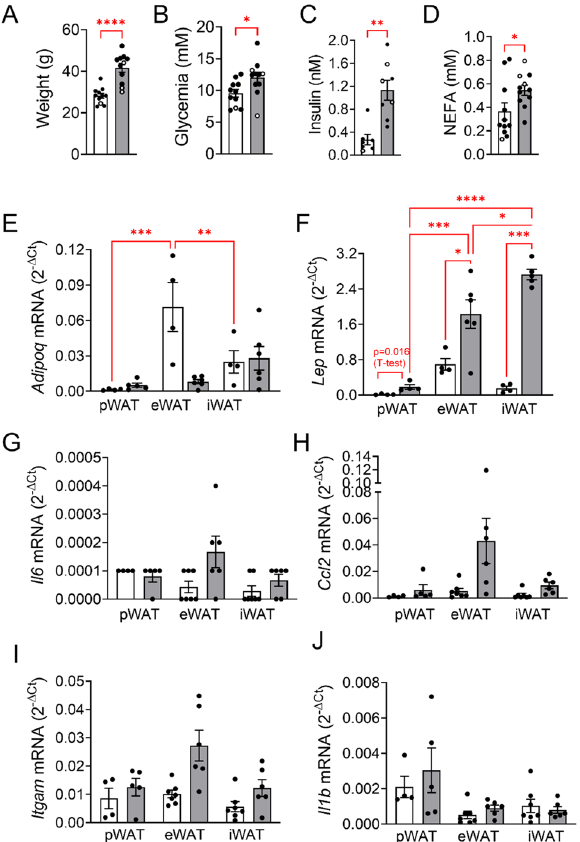
Figure 1. Effects of diet on metabolic traits and adipose tissue characteristics. Mice were fed CD (white bars) and HFD (grey bars). Blood and tissue were collected from male (black dots) and female (white dots) mice at age 24 ± 1.5 weeks ( n = 7–11/group) and analysed as described under Material and methods. ( A ) animal weight, ( B ) blood glucose, ( C ) serum insulin, ( D ) serum fatty acids and ( E-J ) relative mRNA levels of ( E–F ) adipokines, ( G - H ) chemokines and ( I-J ) inflammation markers of pancreatic (pWAT), epididymal (eWAT) and inguinal (iWAT) adipose tissue expressed as 2 −ΔCt relative to Rps13 mRNA (housekeeping gene) are presented as means ± SEM of n individual observations as indicated by the symbols in each plot. * p < 0.05, ** p < 0.01, *** p < 0.001, **** p < 0.0001 denote significant